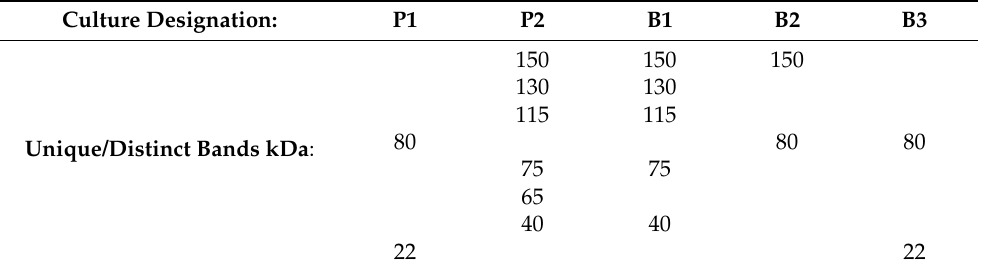
Table 2. Table comparing protein sizes from